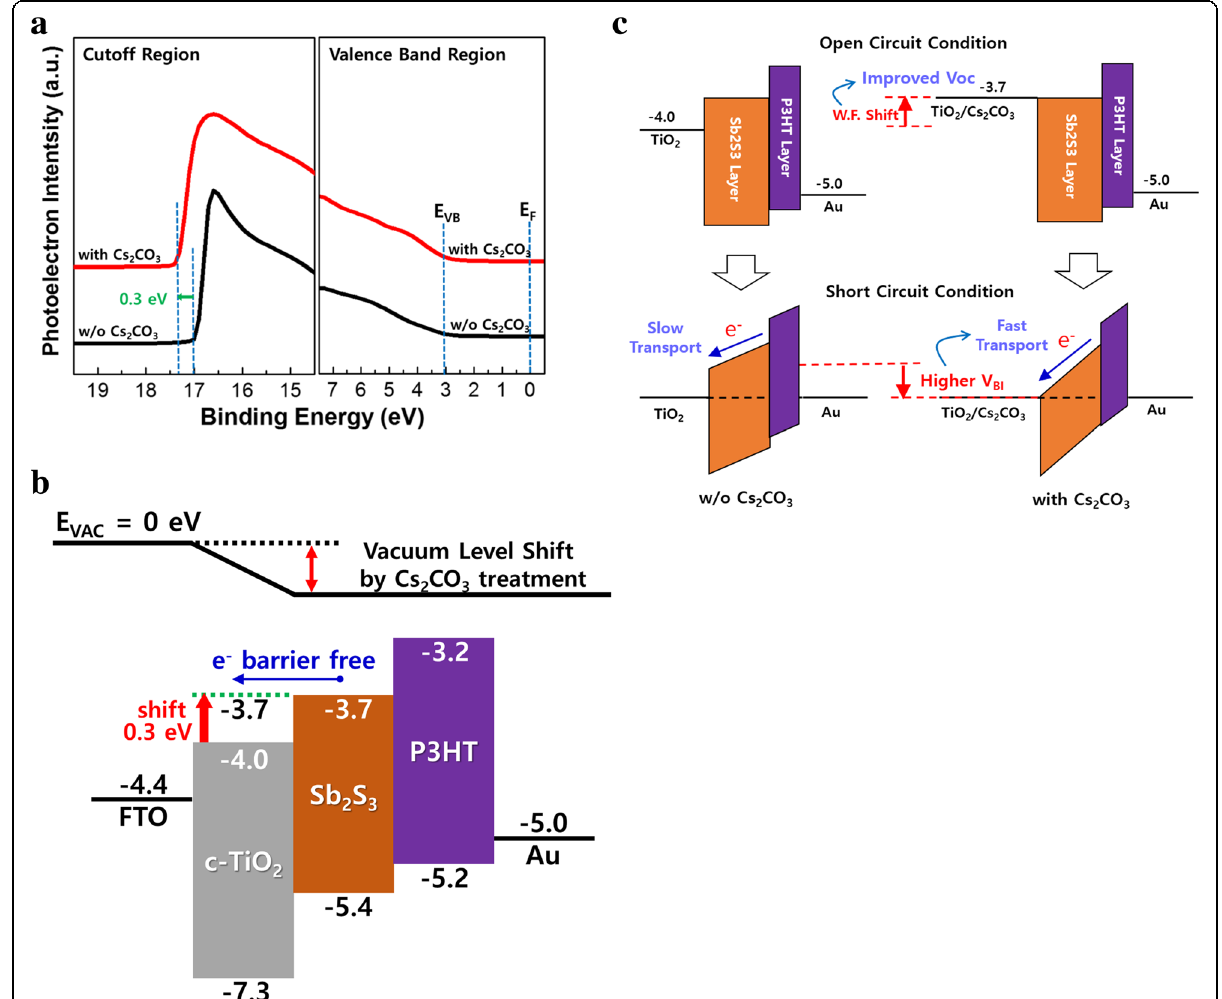
Fig. 7 a UPS spectra of c-TiO 2 , b energy level diagram, and c proposed operating principle of planar-type Sb 2 S 3 solar cells with and without Cs 2 CO 3